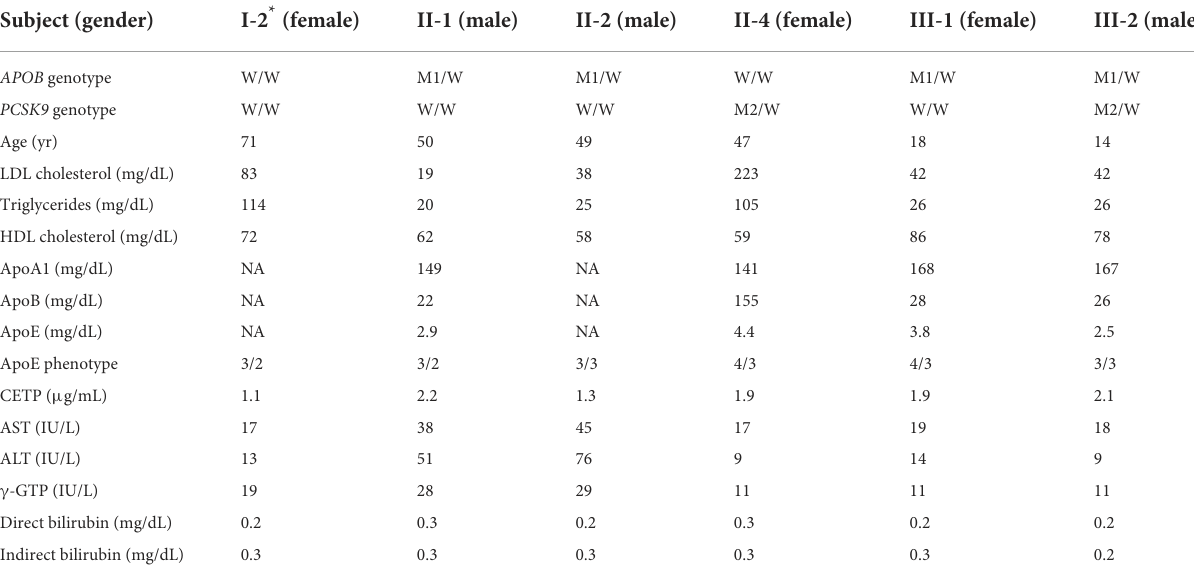
TABLE 1 Clinical and genetic characteristics of the